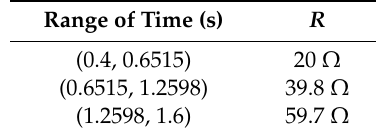
Table 5. Error in the controlled signal.